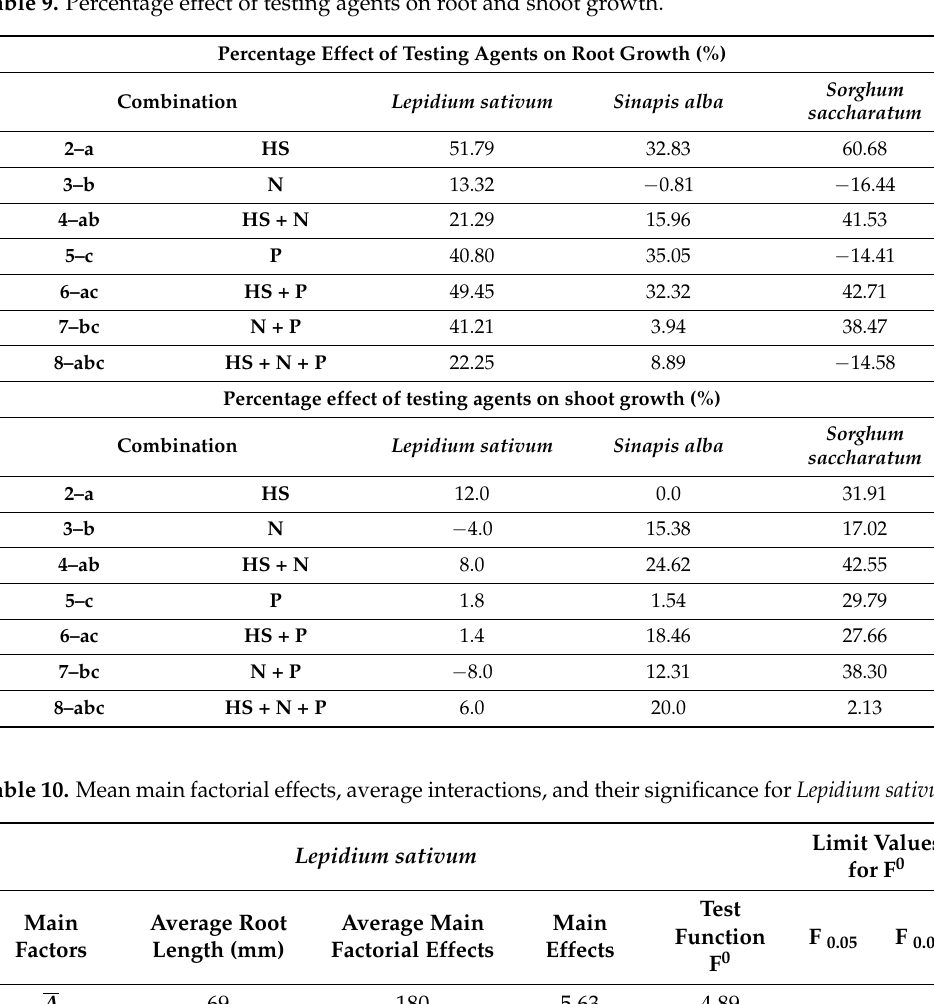
Table 9. Percentage effect of testing agents on root and shoot growth.